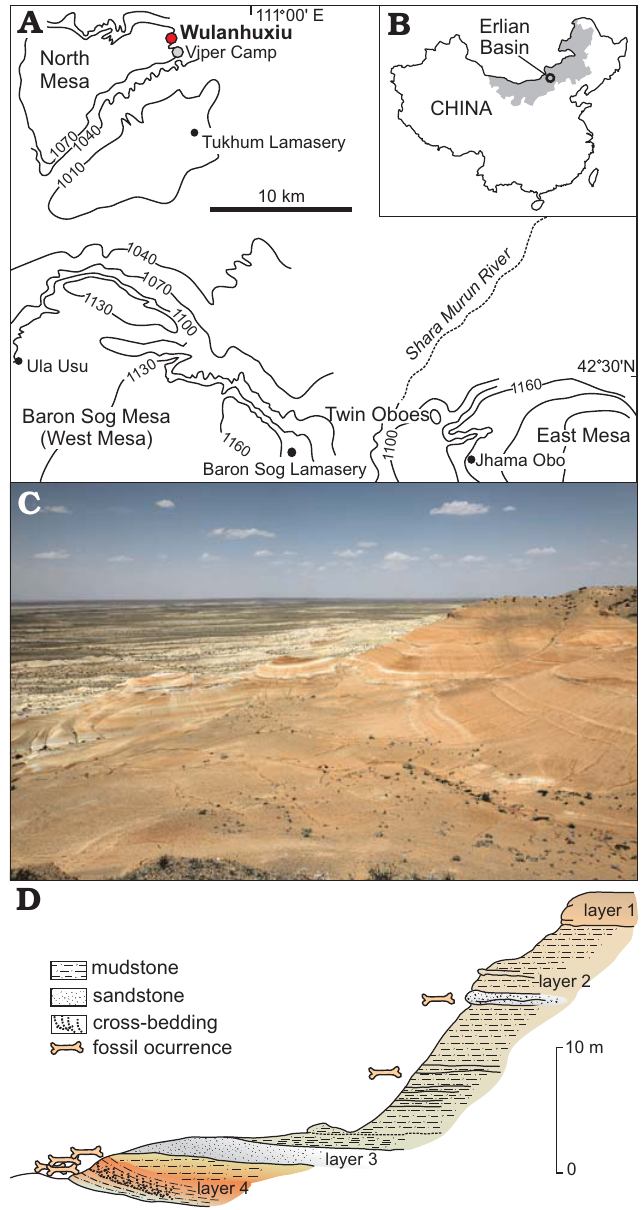
Fig. 1. A . Location of the Wulanhuxiu mammalian fossil site in the western part of the Erlian Basin (elevations given in meters; modified from Russell and Zhai 1987). B . Map of continental China (Nei Mongol Autonomous Region in gray). C . Typical landscape at the Wulanhuxiu locality show- ing fossiliferous beds with the Irdinmanhan–Sharamurunian transition. D . Stratigraphic section of the studied sediment series at Wulanhuxiu (after a field sketch by Bin